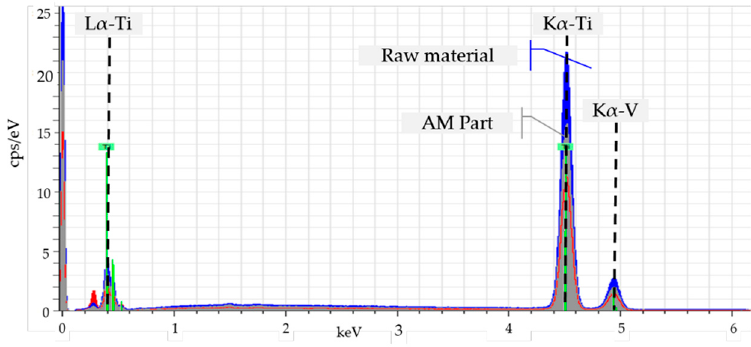
Metals 2019 , 9 , x FOR PEER REVIEW 6 of 8